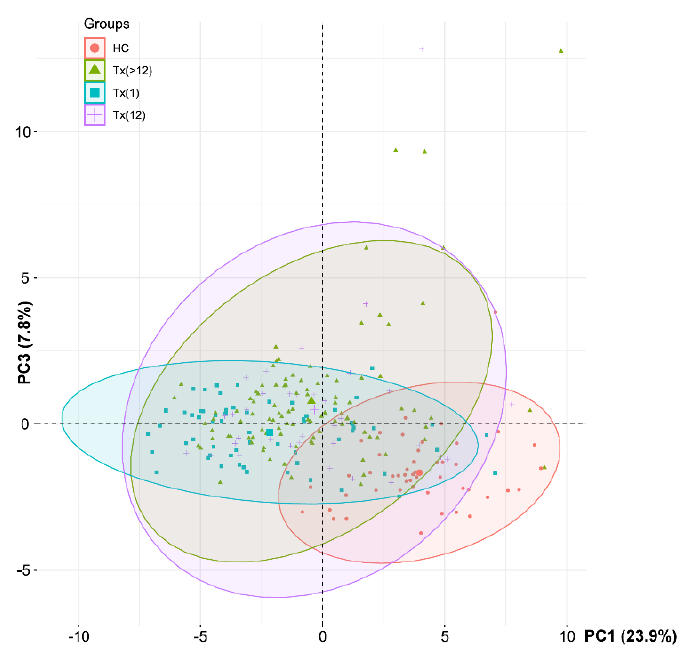
Figure 2. The results of principal component analysis (PCA) of individuals based on the whole serum fatty acid profile. See Figure 1 for the plot of variables. HC – healthy controls; Tx(1)-patients up to one month after the procedure; Tx (12)-patients between 1 month and the first year post-transplant; Tx (>12)-patients in their consecutive years post-transplant.